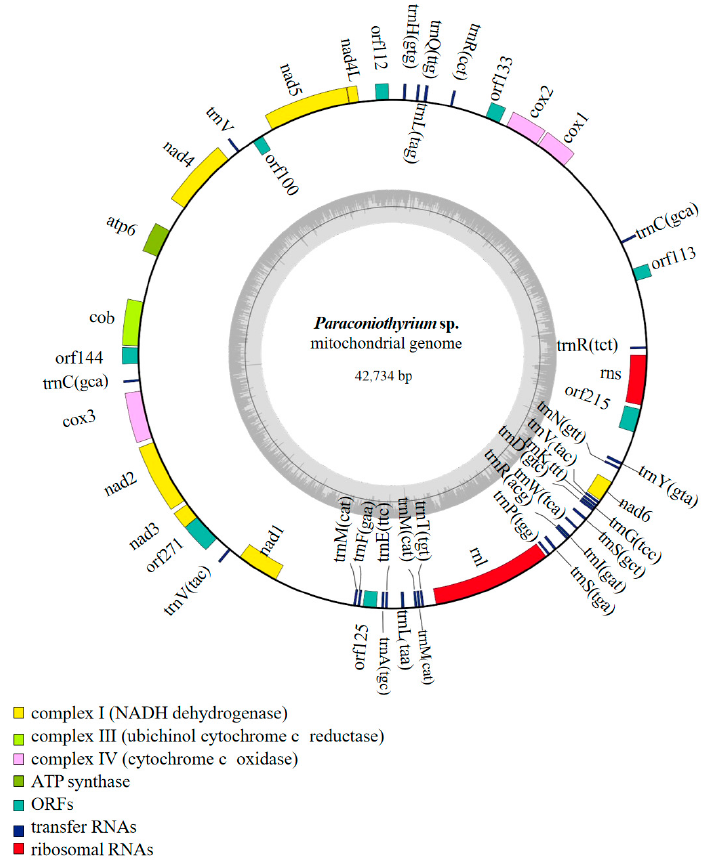
Figure 1. Mitochondrial gene map of Paraconiothyrium sp. YMF1.07793.